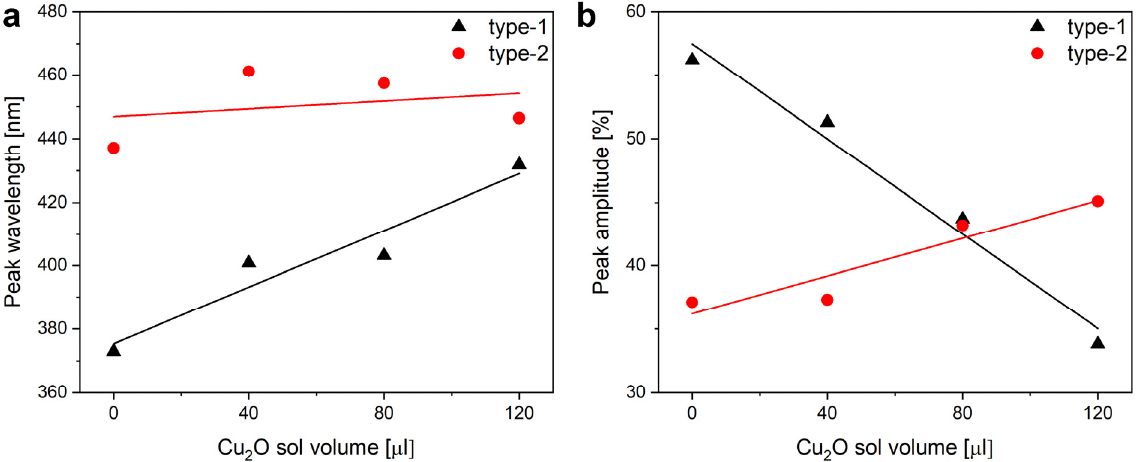
Figure 5. Modifications of the optical properties of the type-1 and of the type-2 samples after the application of the increasing amounts of the Cu 2 O sol onto the wing. ( a ) Peak wavelength and ( b ) peak intensity values are shown with their linear fits to guide the eye.